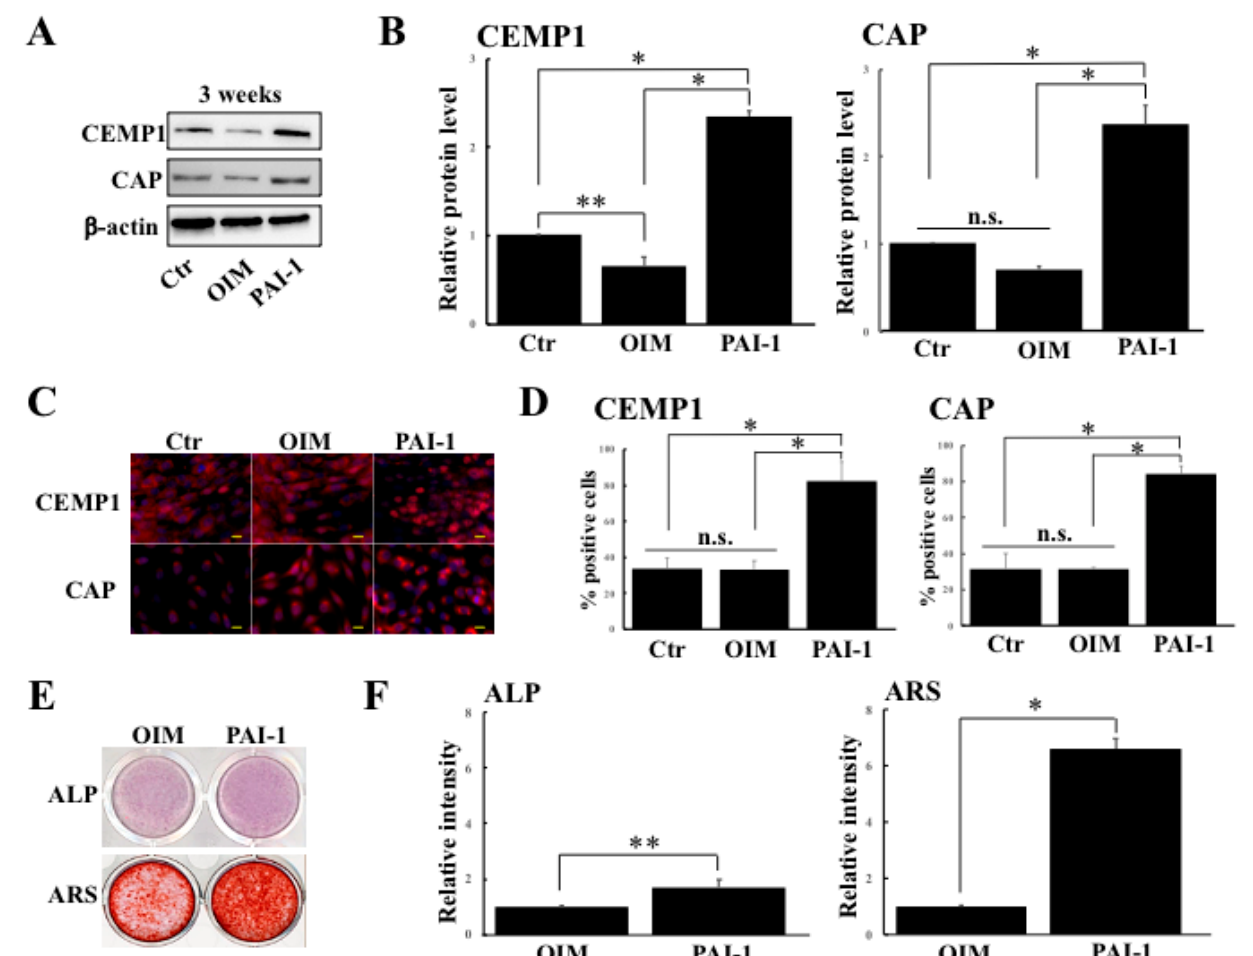
Figure 1. The effect of rhPAI-1 on cementogenic differentiation of HPLSCs in 2D culture. ( A ) Western blot of cementum protein 1 (CEMP1) and cementum attachment protein (CAP) in HPLSCs that were cultured in 2D with DMEM (control), osteogenic inducing medium (OIM) alone, and OIM containing rhPAI-1 (PAI-1; 100 ng/mL) for 3 weeks using β -actin as a loading control. ( B ) Quantification of the protein expression was performed using the ImageQuant LAS4000 biomolecular imager. The relative levels of CEMP1 and CAP expression were normalized to β -actin and were expressed as fold changes compared with HPLSCs that were cultured with DMEM (control). Data represent the mean ± SD of three independent experiments. n.s., not significant, * p < 0.01, ** p < 0.05. ( C ) Fluorescence images of the HPLSCs that were stained with CEMP1 (red) and CAP (red) in 2D culture with DMEM (control), OIM alone (OIM), and OIM containing rhPAI-1 (100 ng/mL) for 3 weeks. The nuclei were counterstained with DAPI (blue). The scale bar represents 20 μ m. ( D ) Semiquantification of the percentage of positive cells that were stained with CEMP1 (nuclei) and CAP (perinuclear cytoplasm). Data represent the mean ± SD of three independent experiments. n.s., not significant, * p < 0.001. ( E ) Staining for ALP activity in the HPLSCs in 2D culture with OIM alone (OIM) or with PAI-1 for 3 weeks. Alizarin red-staining (ARS) was also performed in the cells that were cultured with OIM alone or with PAI-1 for 3 weeks. ( F ) Semiquantification of the staining intensities of ALP and ARS using the WinROOF image analysis software. The relative staining intensities of both ALP and ARS of HPLSCs that were cultured with OIM were expressed as fold changes. Data are displayed as the mean ± SD of three independent experiments. * p < 0.001, ** p < 0.05.